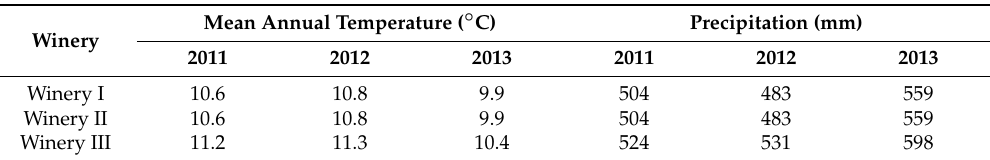
Table 2. Weather data for the three farms investigated.